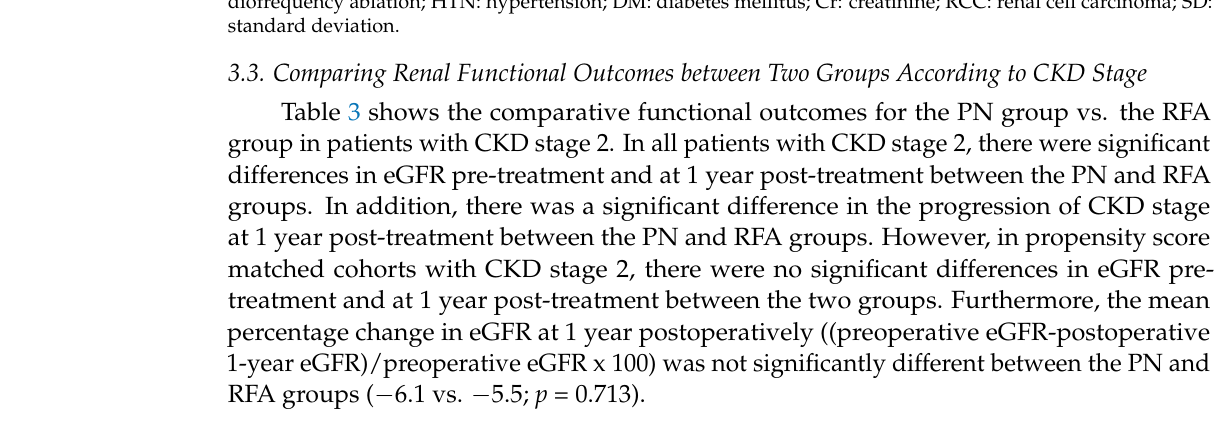
Table 3. Pre- and post-treatment estimated renal function according to treatment method in patients with CKD stage